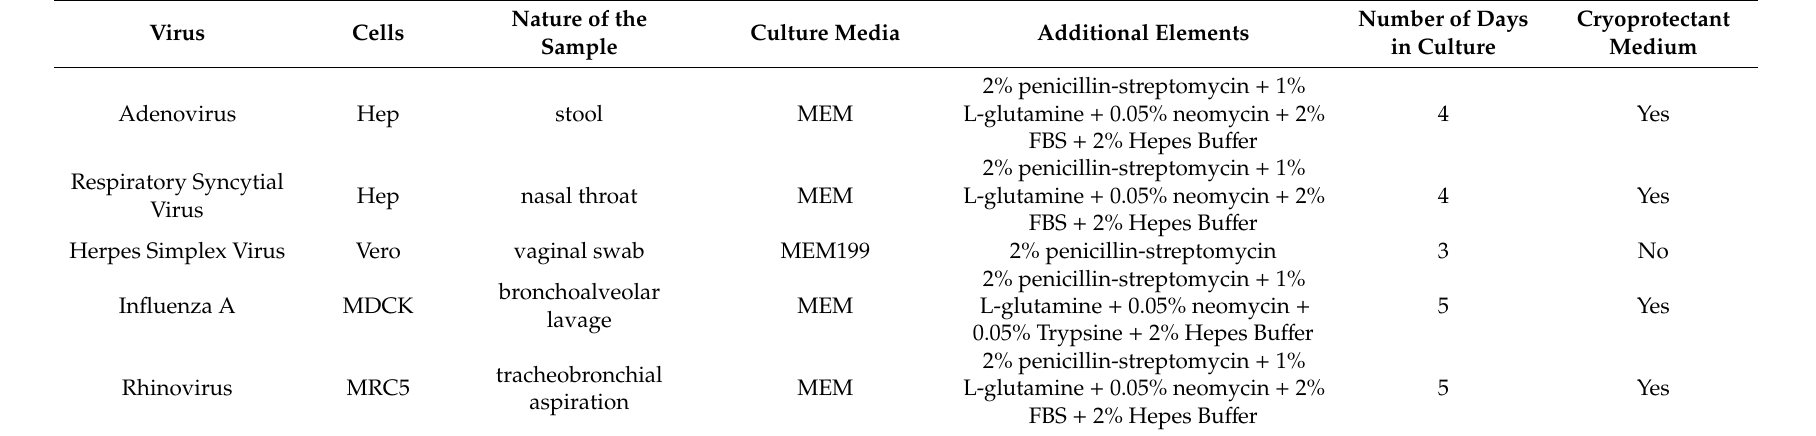
Table 2. Cell culture and media. The di ff erent types of cells used for culture are HEp-2 cells (human liver cancer cells, ATCC CCL-23), Vero cells (monkey kidney epithelial cells, ATCC CCL-81), MRC-5 cells (human fetal lung fibroblasts, Biowhittaker, 25-10-1995 produced by RD-Biotech (Besançon, France)), and MDCK cells (canine kidney epithelial cells, ATCC CCL-34). FBS: foetal bovine serum; HEp-2: human epithelial cell line type 2; MDCK: Madin-Darby canine kidney; MEM: minimal essential